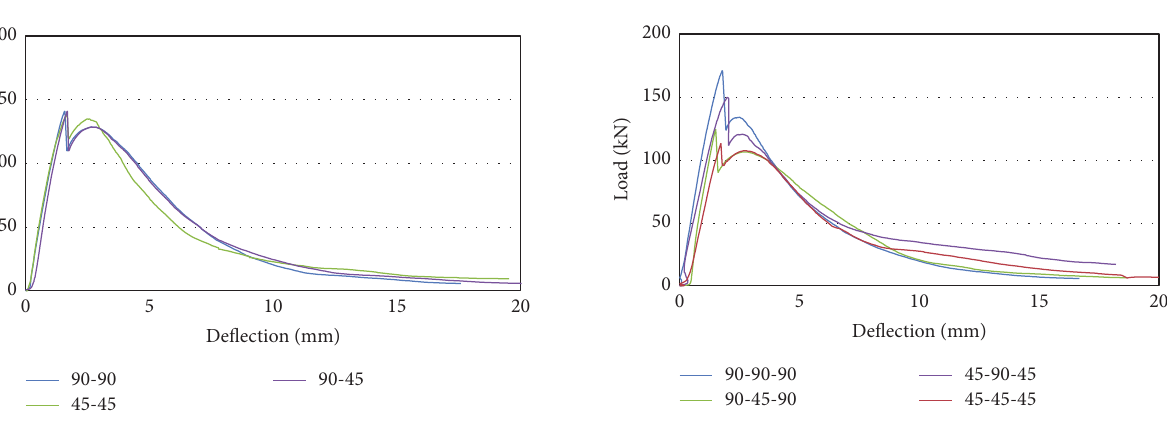
Figure12:Load-midspandeflectioncurvesofdouble-layeredBFRP HPFRCC beam.